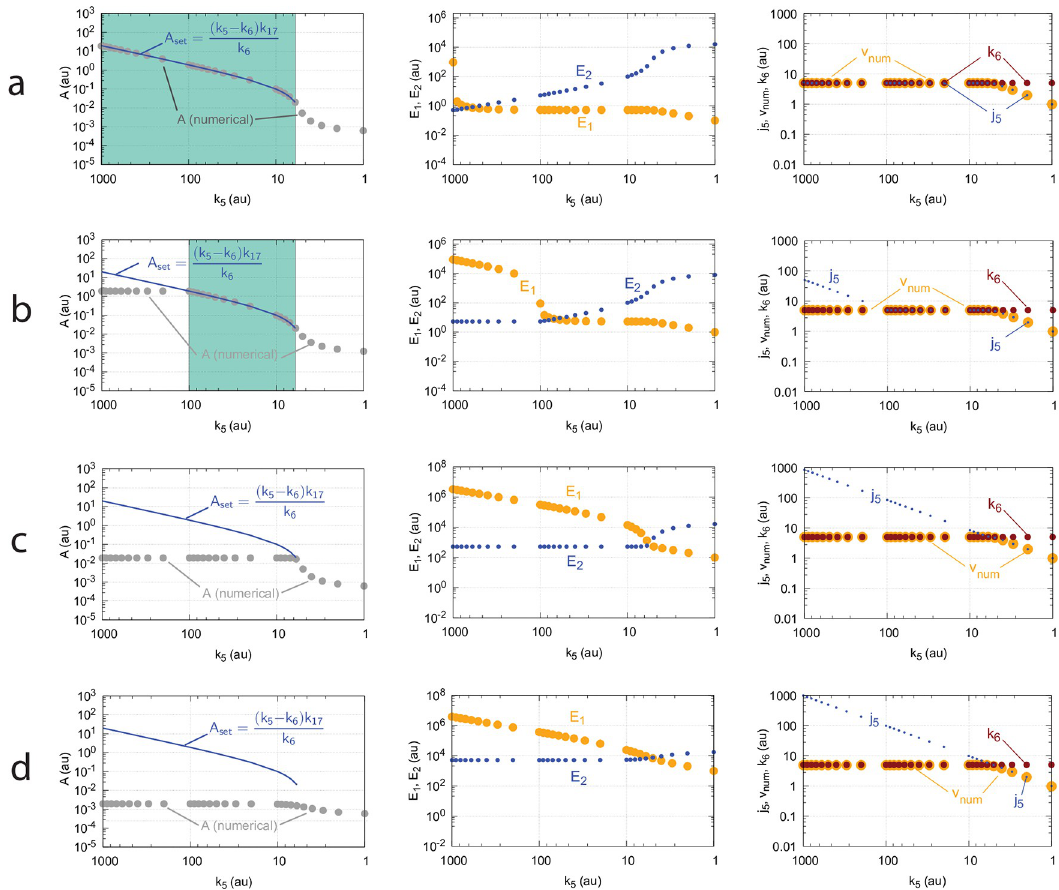
Fig 54. Decrease in the operational range of the enzymatic controller of Fig 51 (in dual-E control mode) as a function to decreased values of the forward enzymatic rate constants k 9 , k 11 , k 13 , and k 15 . The k 6 range for which homeostasis is observed is outlined as turquoise areas. (a) k 9 = k 11 = k 13 = k 15 =1 × 10 7 . (b) k 9 = k 11 = k 13 = k 15 =1 × 10 6 . (c) k 9 = k 11 = k 13 = k 15 =1 × 10 4 . The reverse rate constants k 10 , k 12 , k 13 , k 15 are in (a)-(c) kept constant at 1 × 10 3 . (d) k 9 = k 11 = k 13 = k 15 =1 × 10 3 , while k 10 = k 12 = k 14 = k 16 =0. Despite the irreversibility of the system the k 9 , k 11 , k 13 , and k 15 values are too low to enable homeostasis. Other rate constants (a)-(d): k 1 =100, k 2 = k 3 =0, k 6 =5.0, k 7 =1 × 10 8 , k 17 =0.1. Ez tot =1 × 10 − 6 . Initial concentrations (a)-(d): A 0 =3.000, E 1,0 =1.01 × 10 − 2 , E 2,0 =3.333, Ez 0 =2.994 × 10 − 9 , (E 1 � Ez) 0 =9.102 × 10 − 12 , (E 1 � Ez � E 2 ) 0 =1.0 × 10 − 8 , (EzE 2 ) 0 =9.871 × 10 − 7 , Ez tot =1.0 × 10 − 6